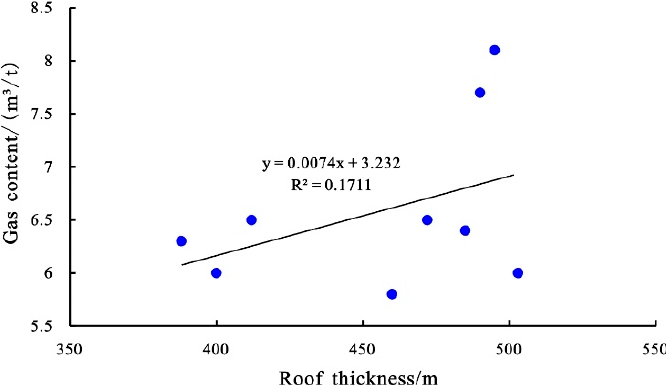
Figure 6. Relationship between overlying stratum thickness and gas content.